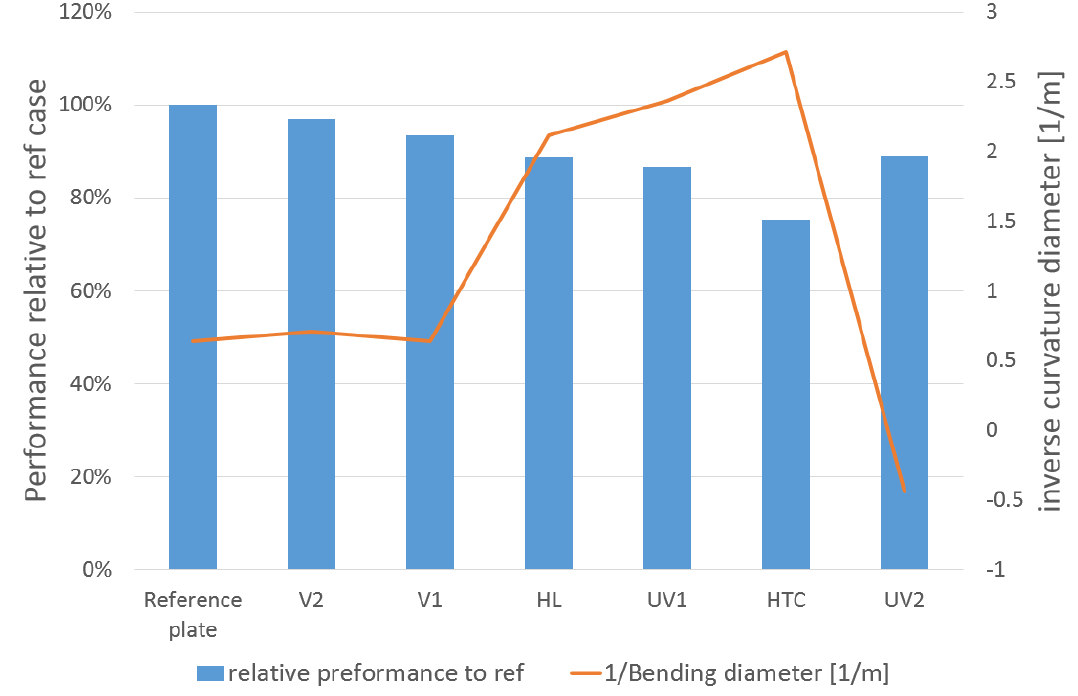
Figure 9. Curvature of tested samples, plotted versus the performance relative to the reference (non-repaired) case.